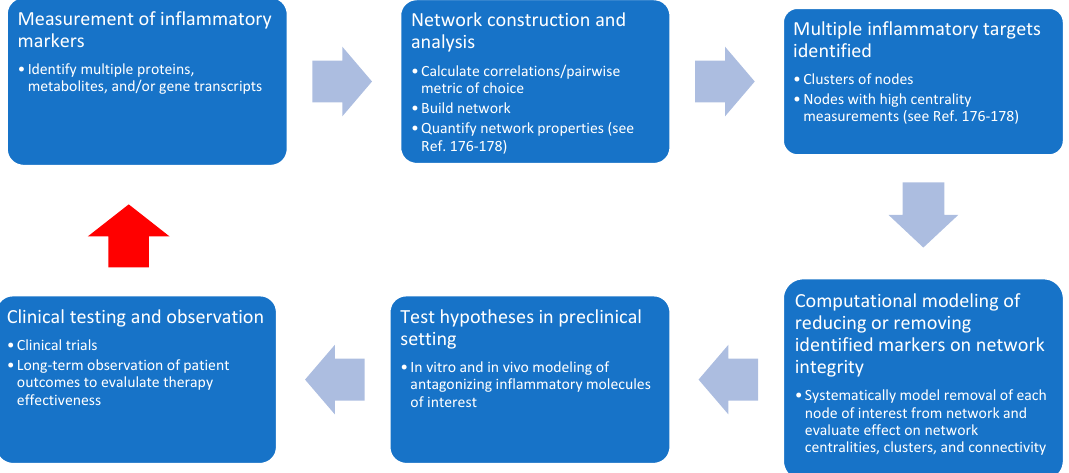
Measurement of inflammatory markers